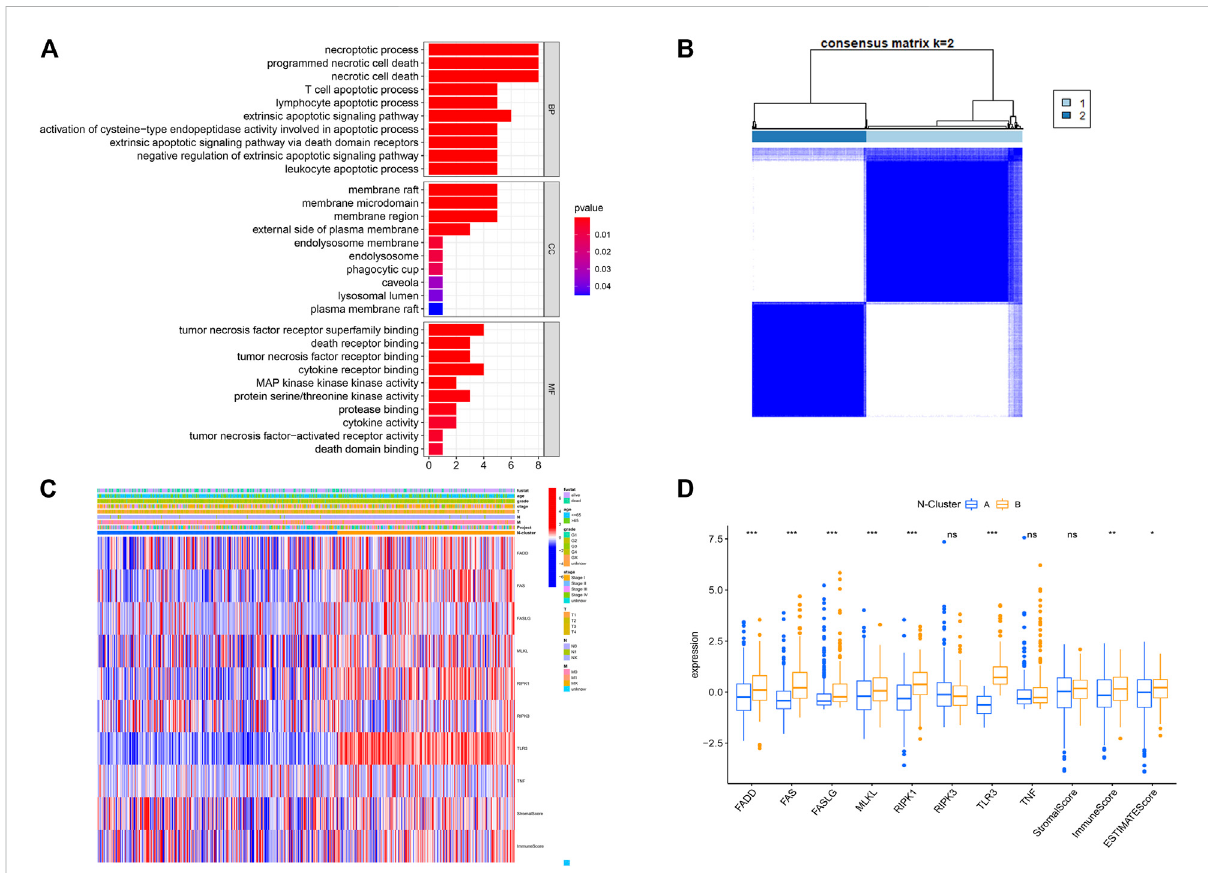
FIGURE 2 Construction ofNecroptosis related cluster (N-Cluster). (A) GeneOntology (GO) analysis for eight Necroptosis-related genes (NRGs) ( p < 0.05, q < 0.05). (B) ConsensusclusteringanalysisbasedontheexpressionlevelsofeightNRGs. (C) Complex heatmaprepresentingthedifferenceinNRGs expression, clinical characteristics, Immune Score, Stromal Score between N-Clusters. (D) Boxplot displaying the differences in NRG expression between N-Clusters (*: p < 0.05, **: p < 0.01, and ***: p <